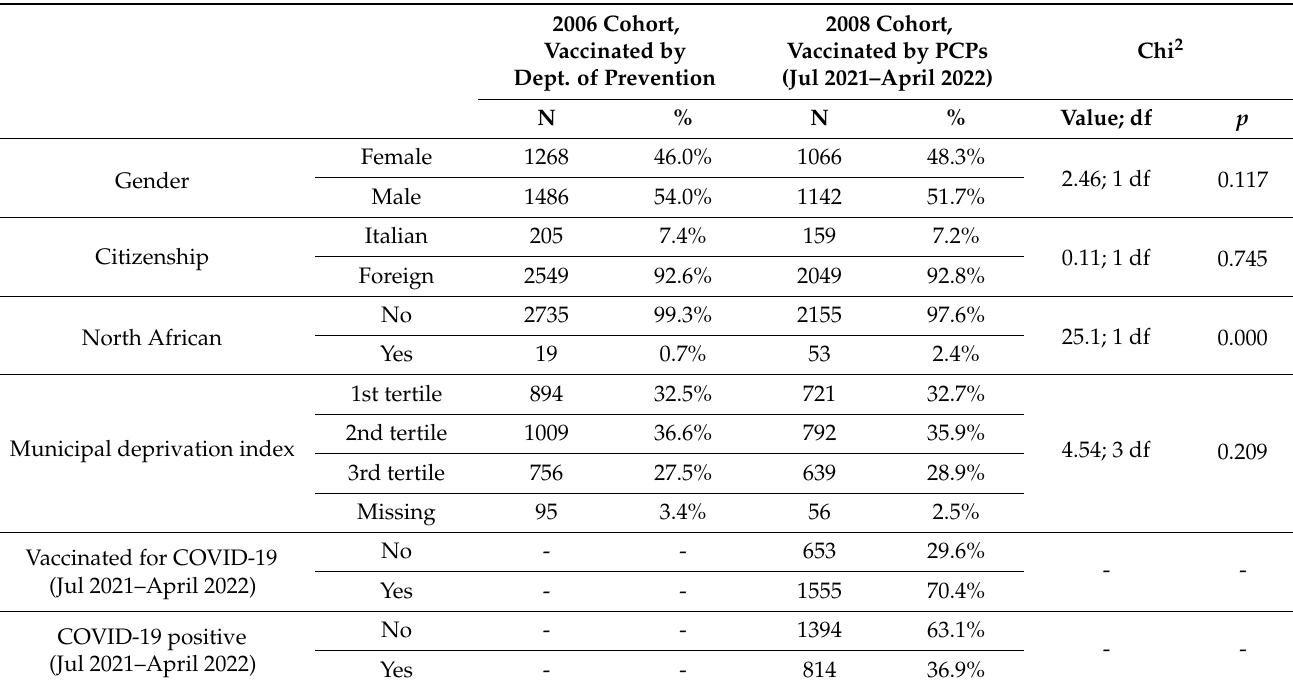
Table 1. Main characteristics of study population (12-year-olds born in 2006 and 2008 and assisted by a primary care physician, Local Health Unit 7, Veneto